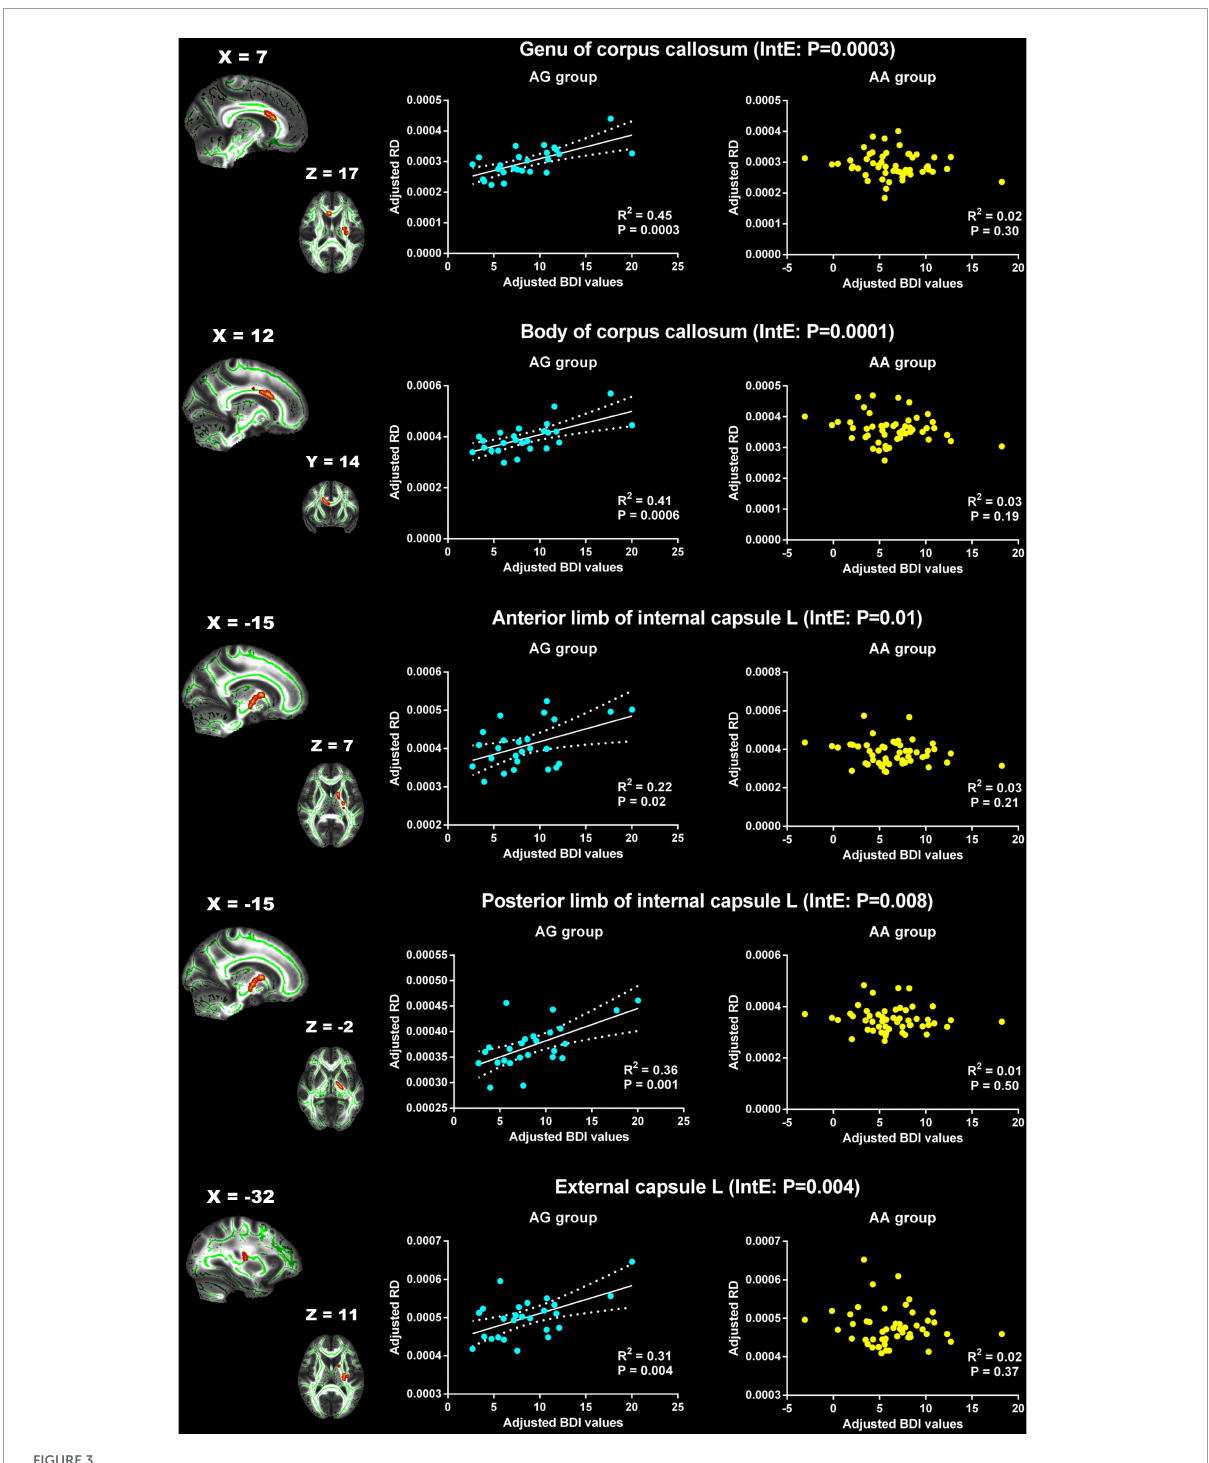
FIGURE3 Significant effects of PER1 genotypes on the associations between BDI values and RD. The significant interaction effects of genotypes × BDI were observed in the white matter tracts of genu of corpus callosum, body of corpus callosum, the left anterior limb of internal capsule, the left posterior limb of internal capsule and the left external capsule. The adjusted BDI and RD were the measures after removing the ten covariates. For the convenience of showing interaction effect, we averaged the adjusted BDI and RD among the voxels in the above WM tracts, and performed the correlation analysis between the adjusted BDI value and RD of WM tracts in each group. BDI, the Beck Depression Inventory; RD, radial diffusivity; L, left. The blue dot represents the AG group; the yellow dot represents the AA group. InE, interaction effects. The white solid line represents the linear regression of the